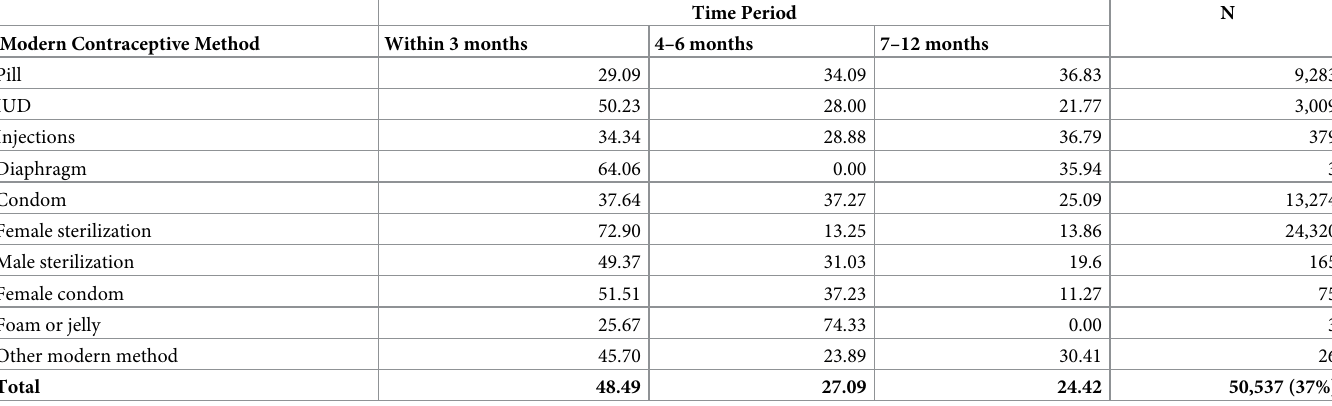
Table 1. Percentage of contraceptive use after having recent birth by postpartum Time Period, India, NFHS-2015-2016. Modern Contraceptive